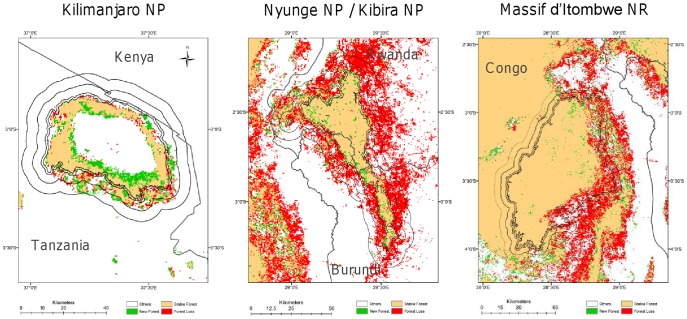
Satellite-derived estimates of forest trend within and around three PAs in East Africa.Forest cover increased (green), decreased (red) or remained constant (orange). Some parks show significant loss in forest cover within their three buffer zones (0–1 km, 1 to 5 km, and 5–10 km). Other land cover transitions are white.